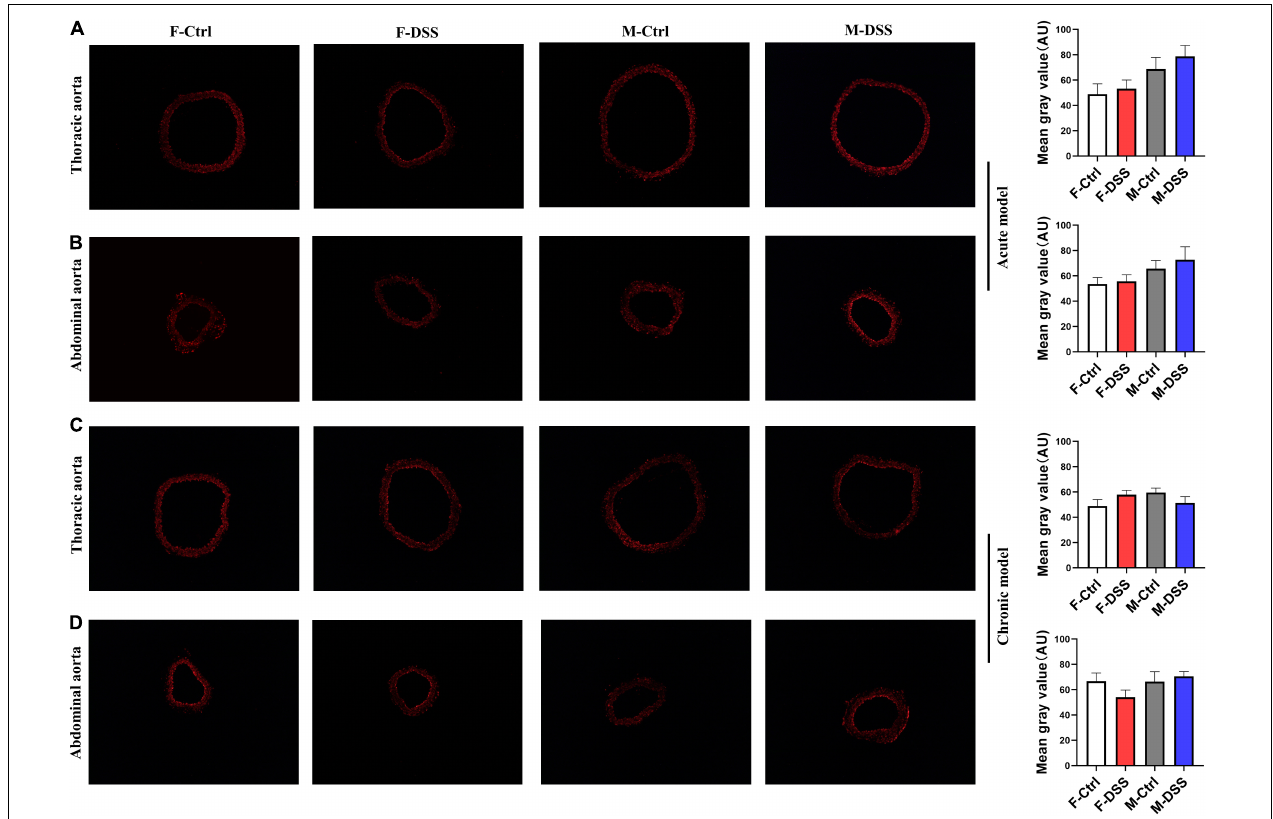
FIGURE 6 | Reactive oxygen species (ROS) levels remained unchanged in thoracic and abdominal aorta in mice with acute and chronic colitis in both female and male mice. Representative images of ROS in acute colitis model (A,B) and chronic colitis model (C,D) for thoracic and abdominal aortic rings using DHE staining ( × 100) and graph for quantification of ROS levels in the aortic rings. Results are expressed as means ± SEM. * p < 0.05, in unpaired 2-tailed Student’s t -test (A–D) , n = 5 mice in each group. DHE, dihydroethidium. AU, arbitrary units. F and M, female and male mice,